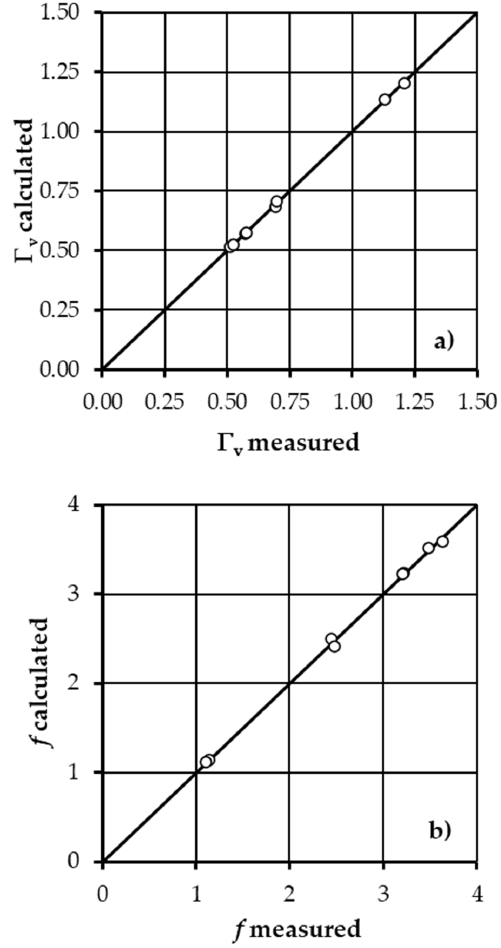
Figure 2. Comparison, for BC = 0 kg m − 2 , between the measured Γ v values, obtained by Equation (6), and those calculated by Equation (9) ( a ) and between the measured friction factor values, and the ones, f , calculated by Equation (5) with Γ v values estimated by Equation (9) ( b ). For testing the effect of the biochar content BC on the rill flow resistance equation, the following equation was applied: